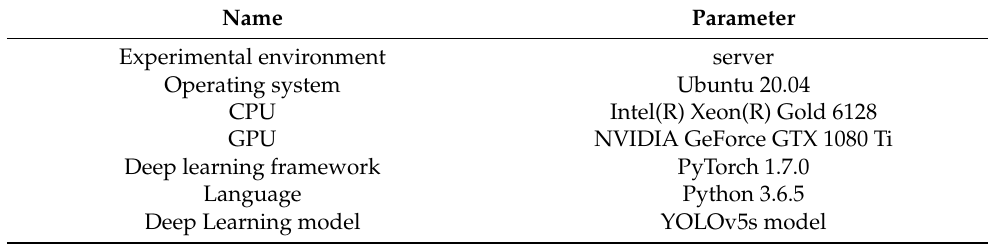
Table 2. Information about Hardware and Software experimental environment.